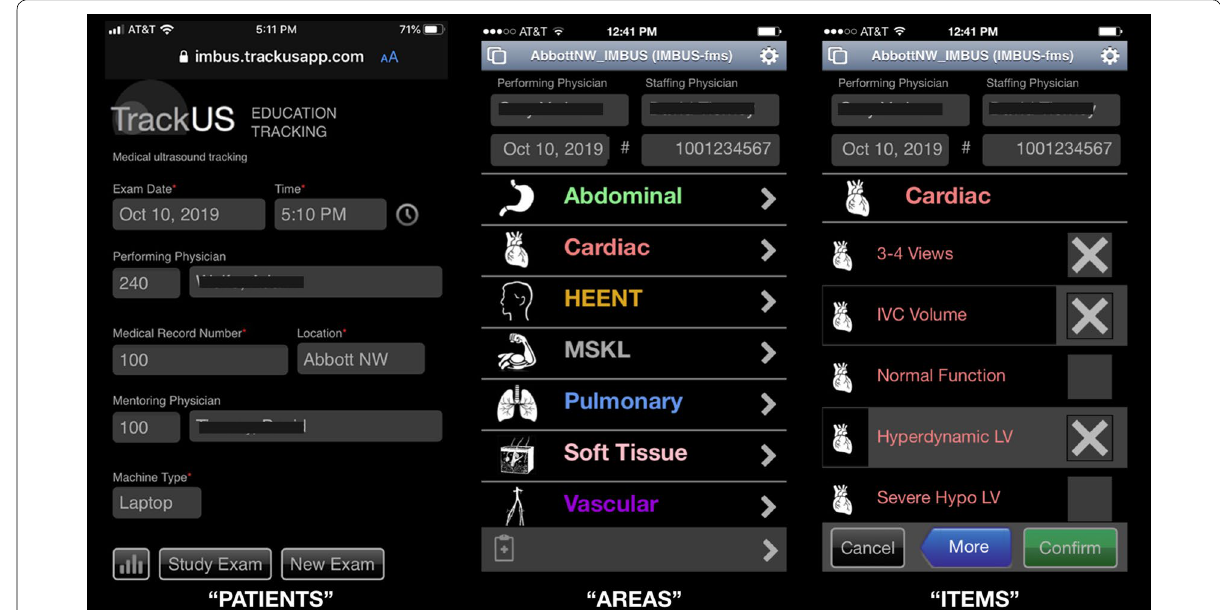
Fig. 1 Smartphone-based tracking application used to record “PATIENT” exams, “AREAS” examined on each patient, and “ITEMS” observed in each area